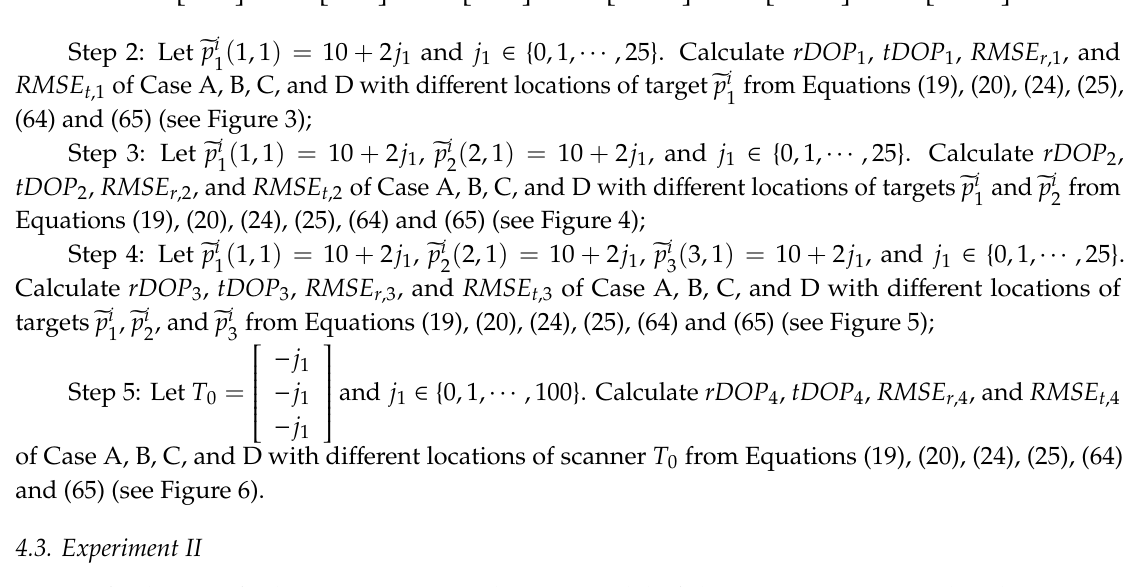
rDOP , tDOP , RMSE , and RMSE of Case A, B, C, and D with respect to one Figure 3. 1 1 ,1 r ,1 t different target.